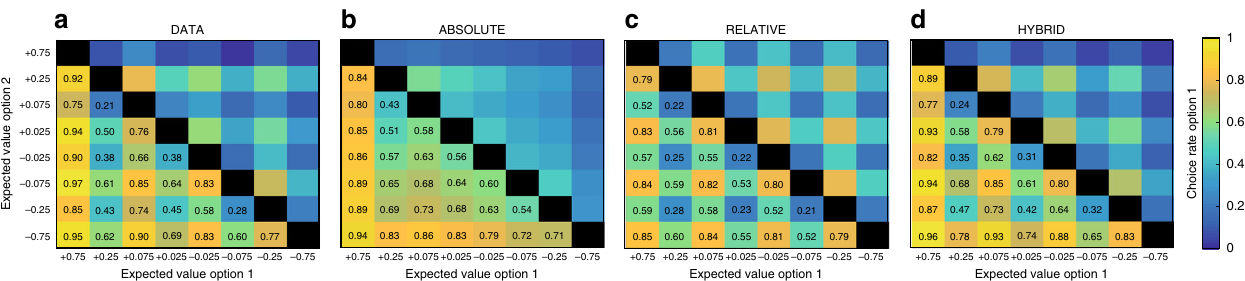
Fig. 3 Transfer test behavioral results and model simulations. Colored map of pairwise choice rates during the transfer test for each symbol when compared to each of the seven other symbols, noted here generically as ‘ option 1 ′ and ‘ option 2 ′ . Comparisons between the same symbols are unde fi ned (black squares). a Experimental data, b ABSOLUTE model, c RELATIVE model, and d HYBRID model